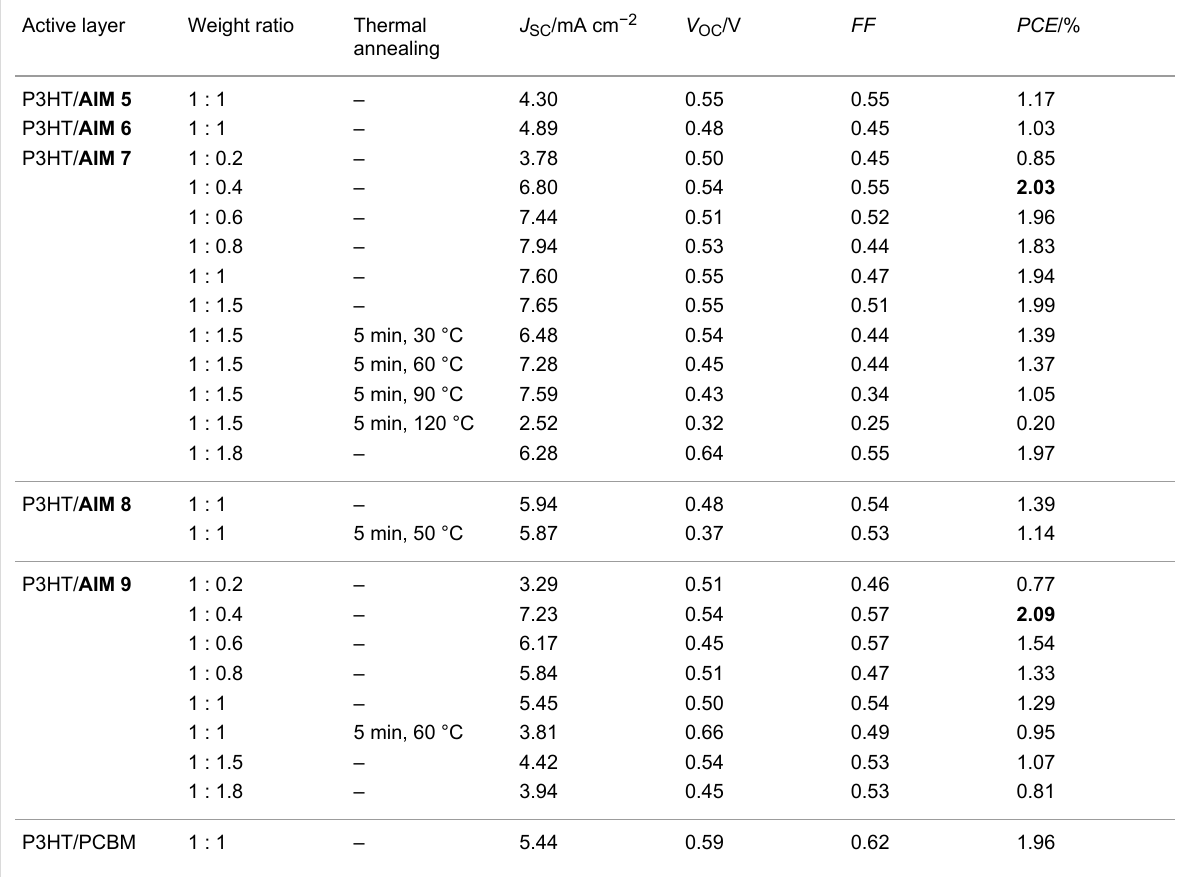
J SC /mA cm − 2 V OC /V annealing